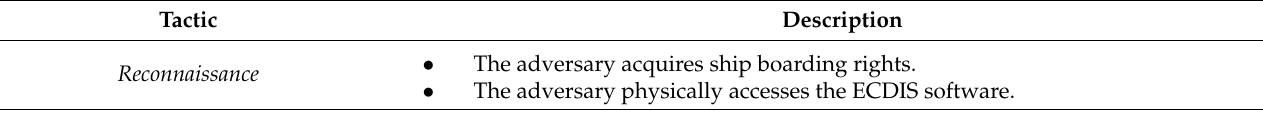
Table 4. MITRE ATT&CK analysis results for attack case 2.